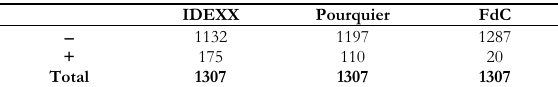
Marginal distribution of IDEXX, Pourquier and FdC IDEXX